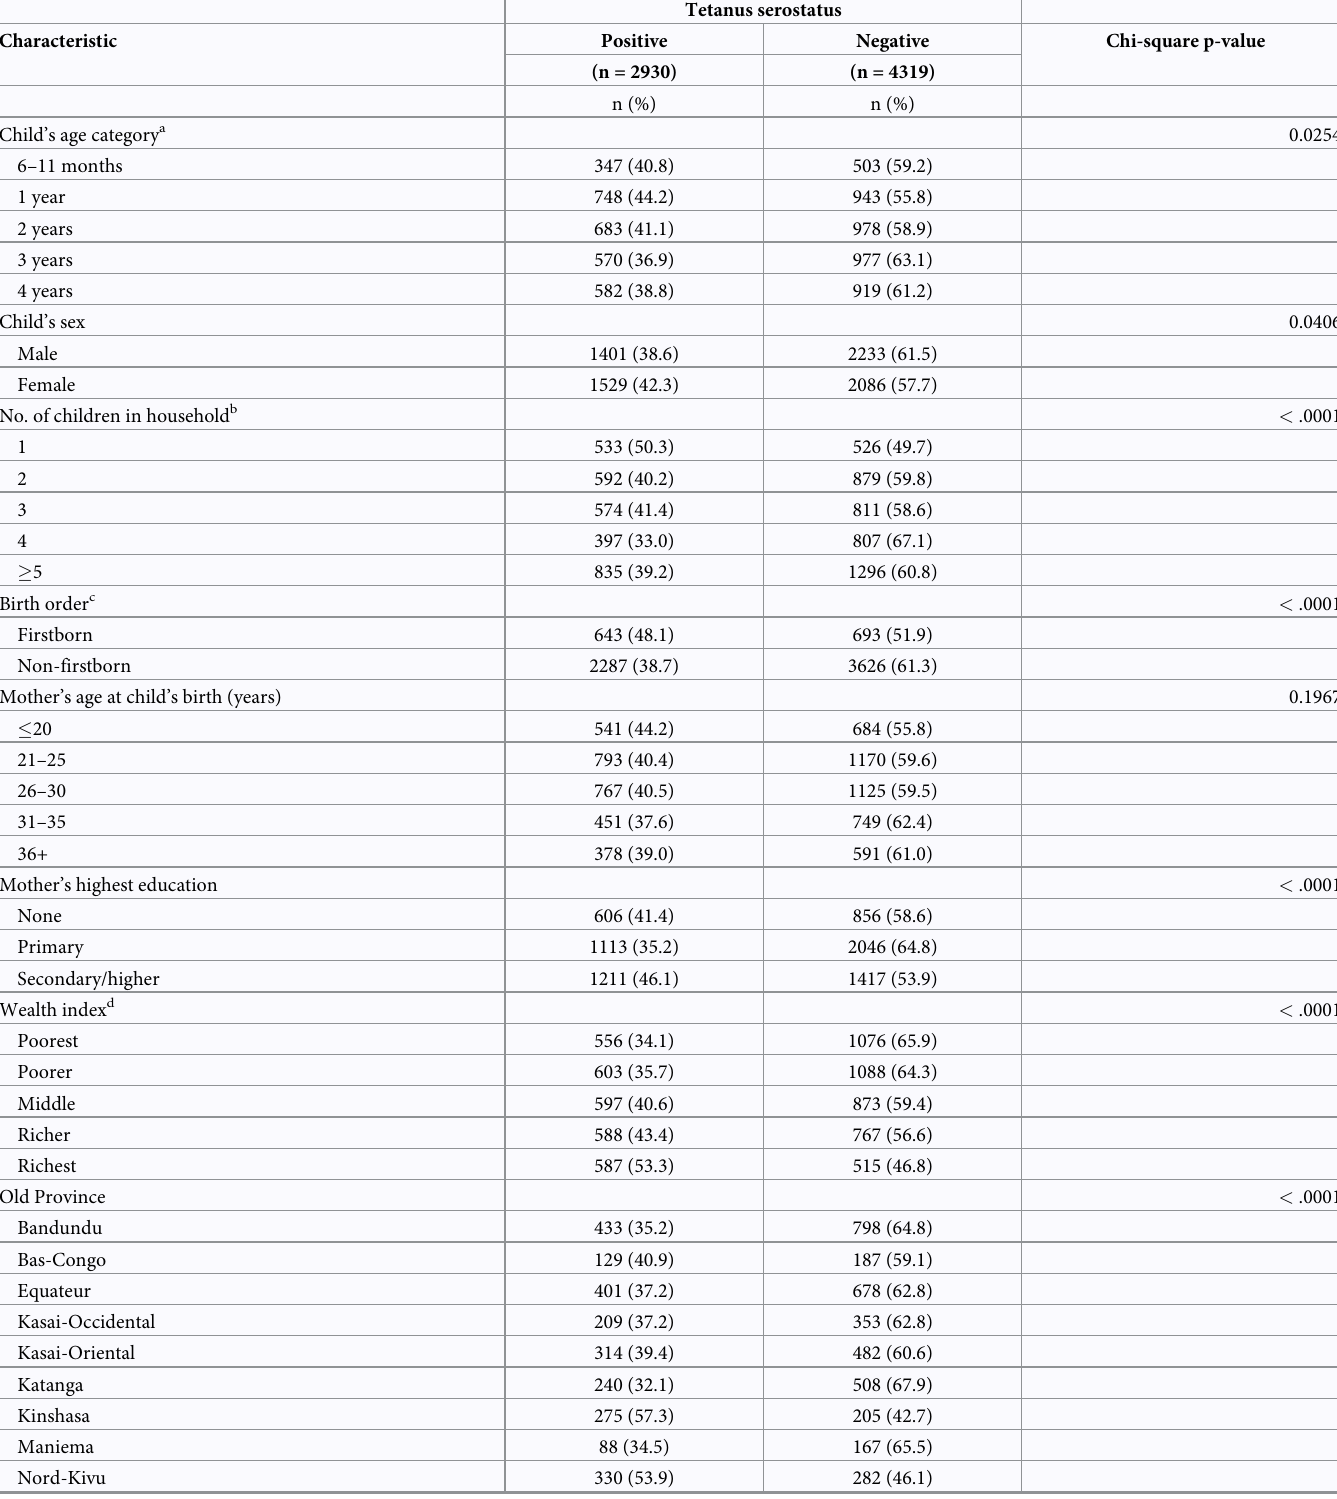
Table 1. Weighted demographic characteristics by tetanus serostatus result of children 6–59 months old in the EDS-RDC